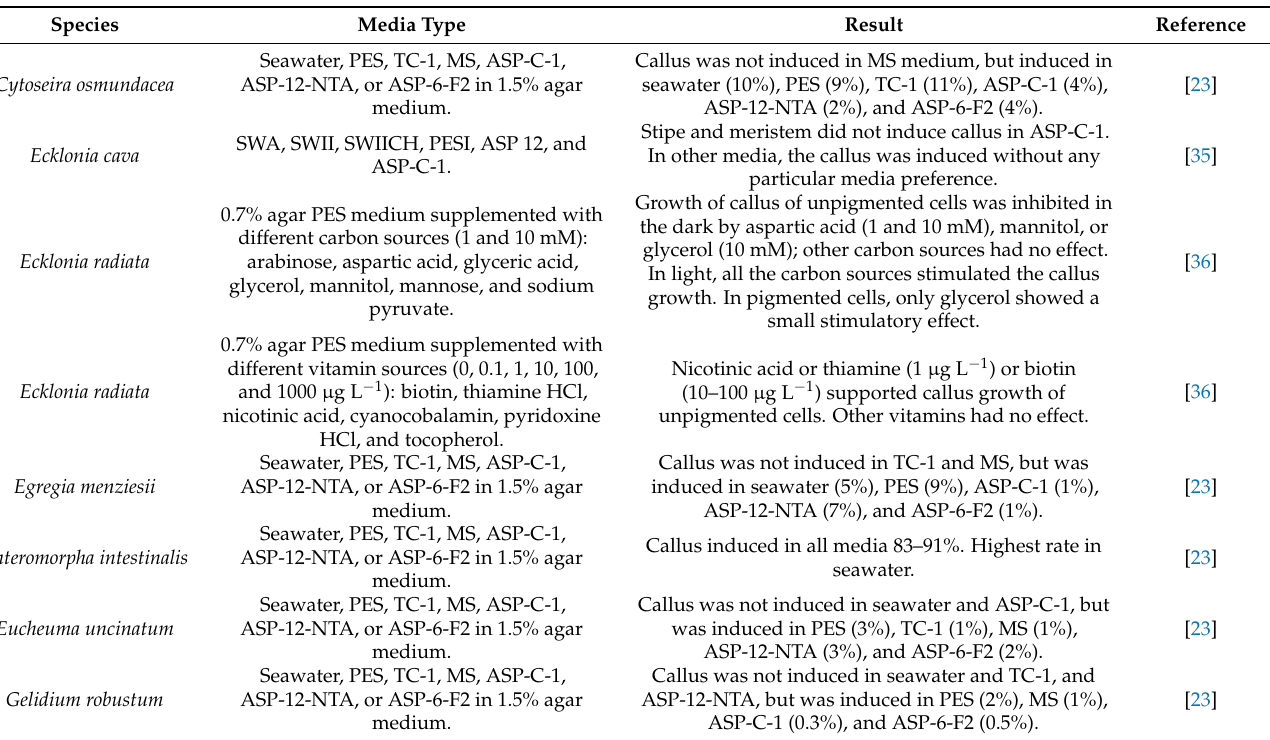
Table 3. Studies on the influence of media type on callus induction in